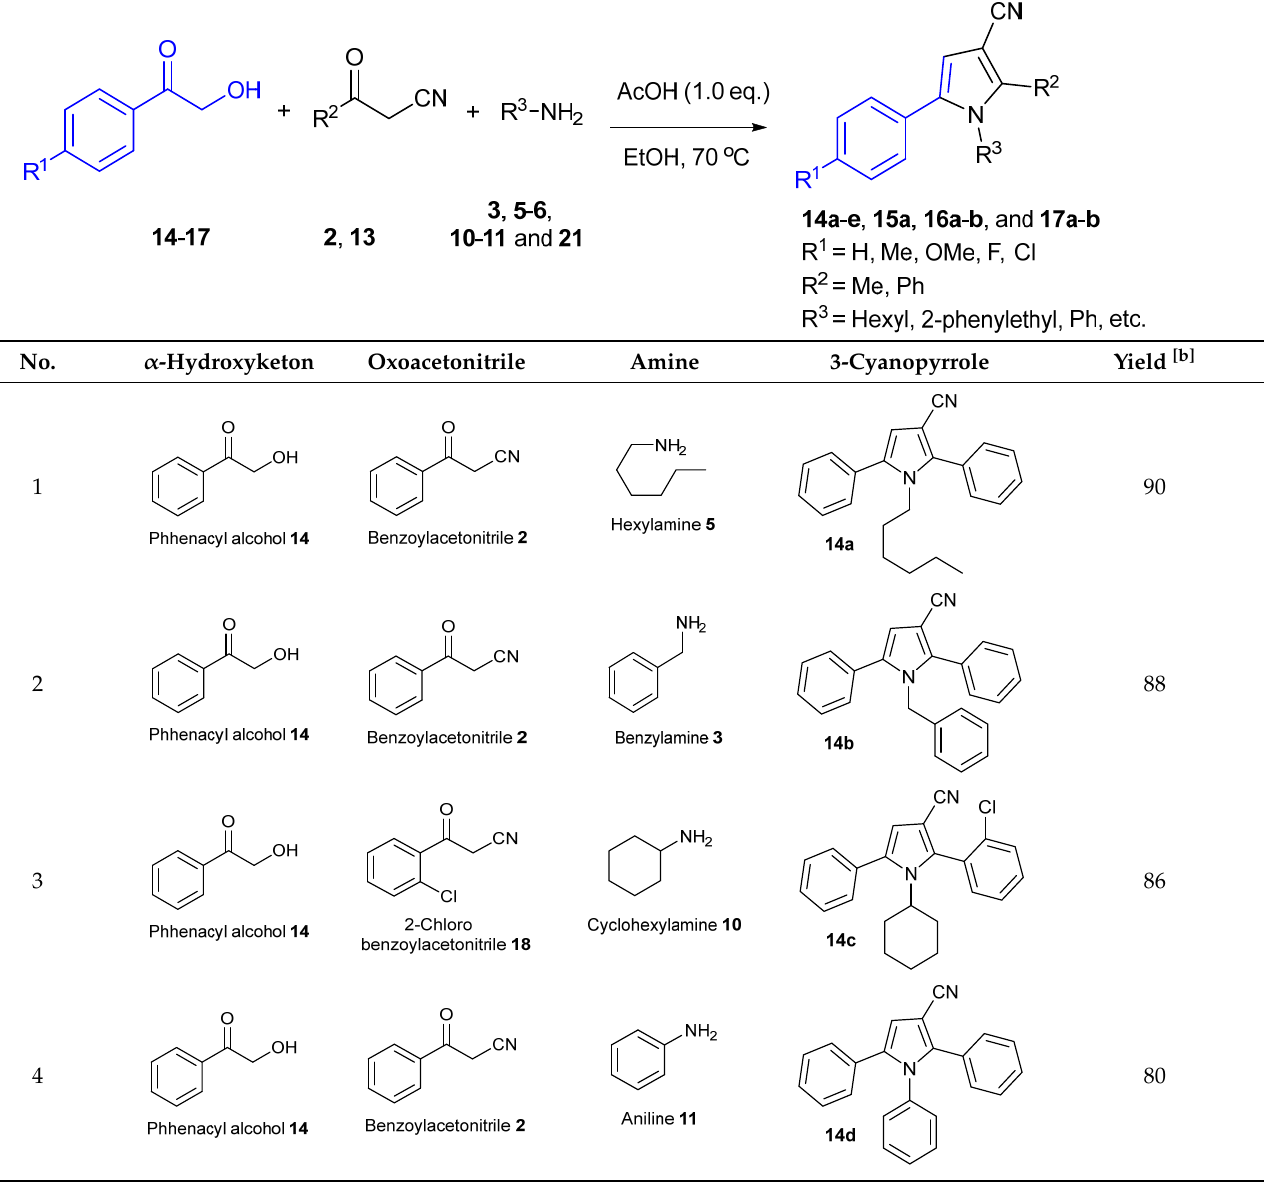
Table 3. The substrate scope of the AcOH-catalyzed three-component reaction between phenacyl alcohols 14 – 17 , oxoacetonitriles 2 , 13 , and 18 – 20 , and primary amines 3 , 5 , 6 , 10 , 11 , and 21 for the selective synthesis of 3-cyanopyrroles 14a – e , 15a , 16a – b , and 17a – b . [a].